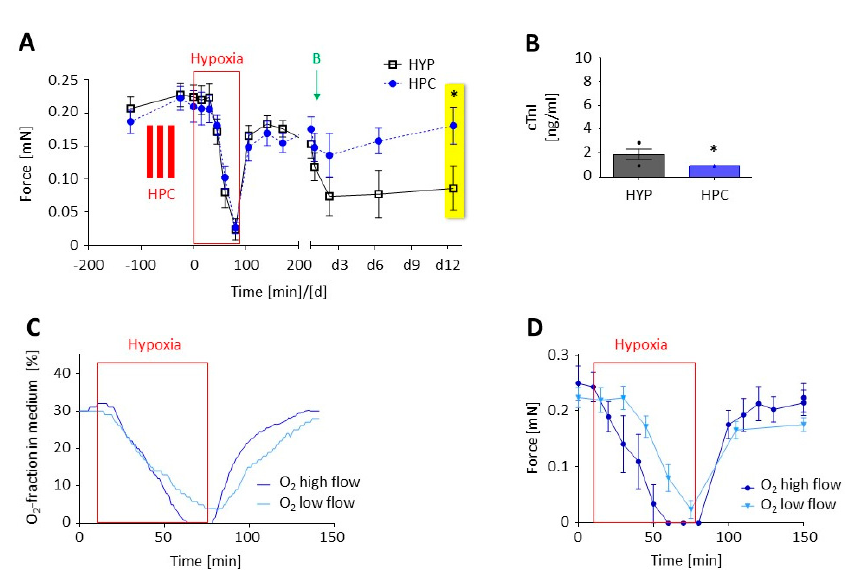
Figure 3. ( A , B ) Effect of hypoxic preconditioning (HPC, 3 × 10 min) followed by 90 min hypoxia compared to the hypoxic group without preconditioning (HYP). Data are presented as mean ± SEM. ( A ) Force (mN) before, during and after hypoxia in early (0–2 h) and late ( ≥ 2 days) reoxygenation. Two-way ANOVA and Sidak’s post-test at day 12 (yellow box, n = 10 per group, * p = 0.024). ( B ) Release of cardiac troponin I (cTnI) in the first 24 h (see arrow in A) after reoxygenation. Unpaired t-test ( n = 6–7, * p = 0.031). ( C , D ) Impact of gas flow rates on the O 2 -fraction in the medium and on force. ( C ) O 2 -fraction measured in the medium during hypoxia experiments at high (5 L/min) or low gas flow (0.5 L/min) in the hypoxic chamber. The oxygen concentration inside the incubator (gas phases), as well as in the medium (5 mm below the surface, liquid phase), was determined with an oxygen microprobe based on fluorescent light emission (Microx-TX transmitter, tip diameter < 50 µm; Presens Precision Sensing GmbH, Regensburg, Germany). ( D ) Corresponding changes of the contractile force over time. 3.3. Preconditioning with a δ -opioid Receptor Agonist (DADLE) To explore drug-induced preconditioning, we used the δ -opioid receptor agonist [ D -Ala2, D - Leu5]-enkephalin (DADLE). Again, we exposed rat EHTs to 90 min of hypoxia in lactate medium and reoxygenation in glucose medium (group “HYP”). This time the EHTs in the treatment group were incubated in lactate medium containing 100 nM DADLE (group “DA”) or 100 nM DADLE plus 10 µM naloxone (group “N+DA”) for three cycles of 10 min preconditioning. Contractile force recovered significantly better in the DA group than in the HYP group (Figure 4A). This effect was partly antagonized by naloxone. Accordingly, in the DA group G6PDH release was lower compared to the HYP group (Figure 4B). The cTnI analyses revealed no statistically significant differences between all groups (Figure 4C). The protective effect of DADLE preconditioning was maintained. Seven days after induction of hypoxia-reoxygenation injury the force in the DA group was lower than the time control without hypoxia, but significantly better than the hypoxic HYP group without conditioning (Figure 4D).